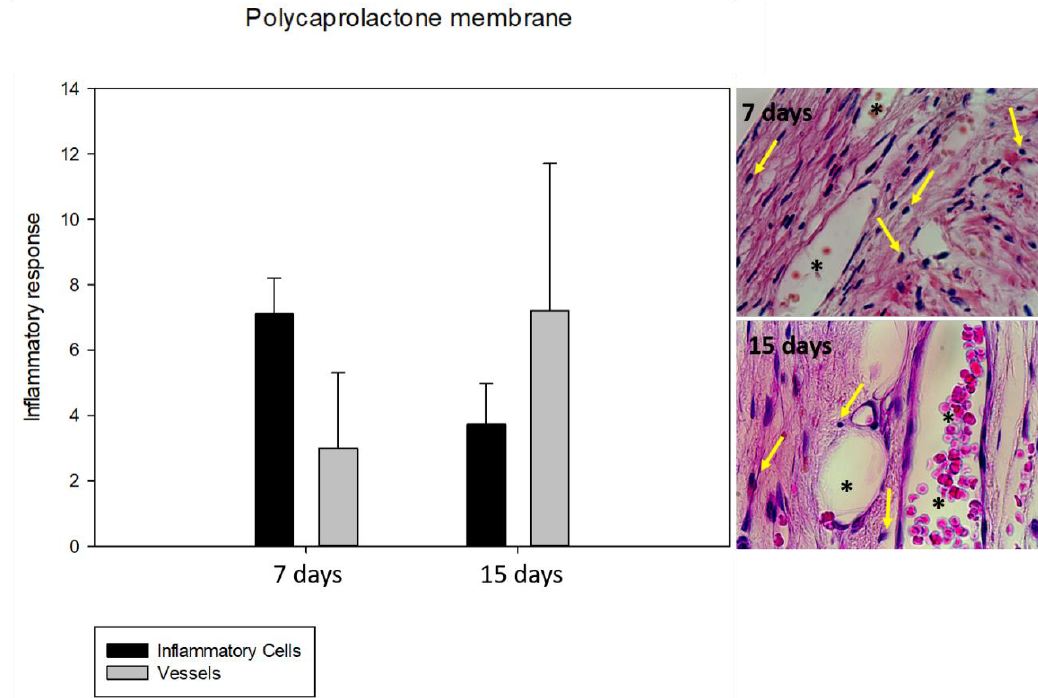
Figure 3. Graph and photomicrographs (×100) demonstrating the average number of inflammatory cells and vessels in the BG group during the periods analyzed. Regarding the biological behavior of the polycaprolactone membrane, there was a decrease in the number of inflammatory cells and an increase in the number of vessels. * indicates blood